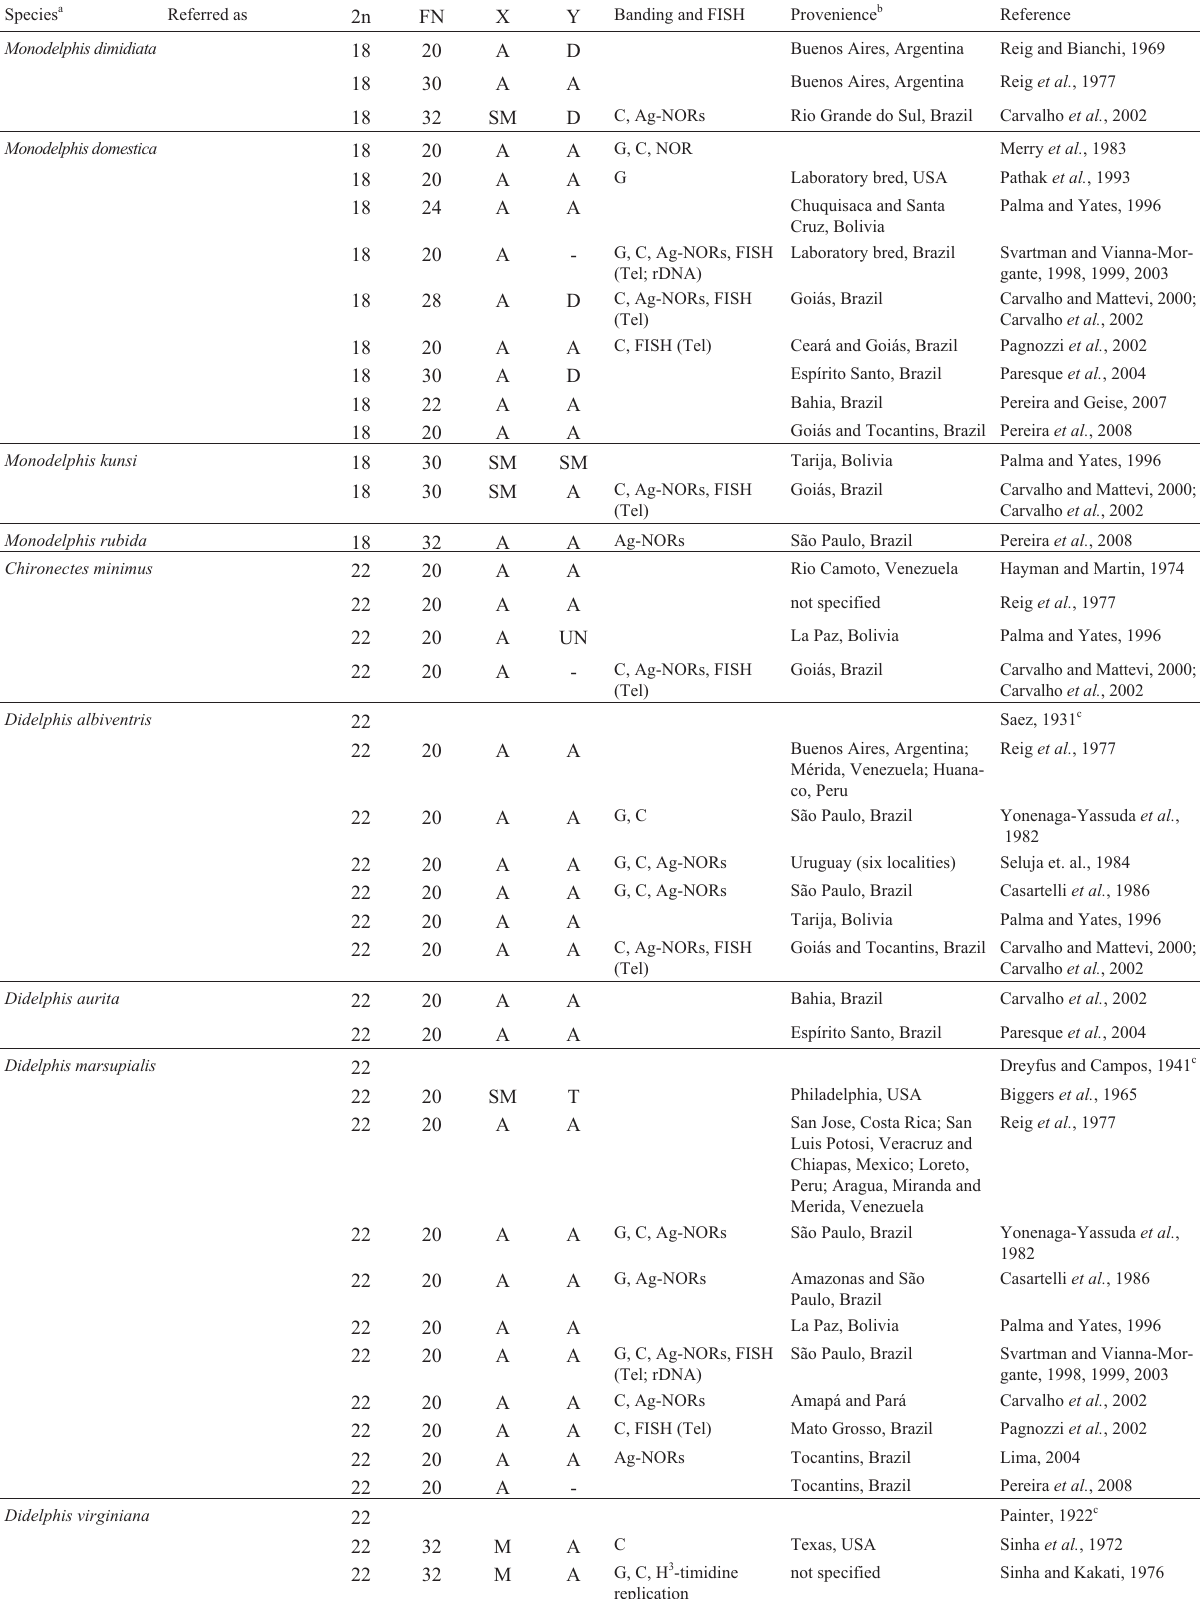
Table 1 (cont.) Species a